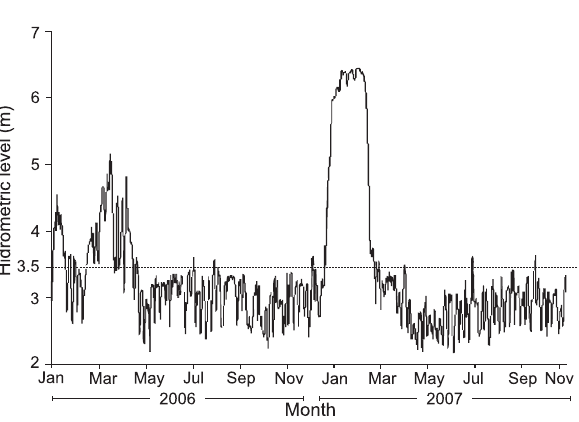
Figure 2. Hydrological regime of the Paraná River measured at Porto São José municipality. Stippled line = water level required for initial inundation of the floodplain (Source: Fluviometric Station’s Porto São